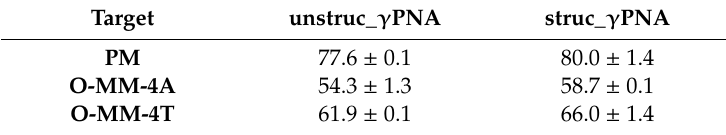
Table 2. UV melting temperature ( ◦ C) for select γ PNA-DNA